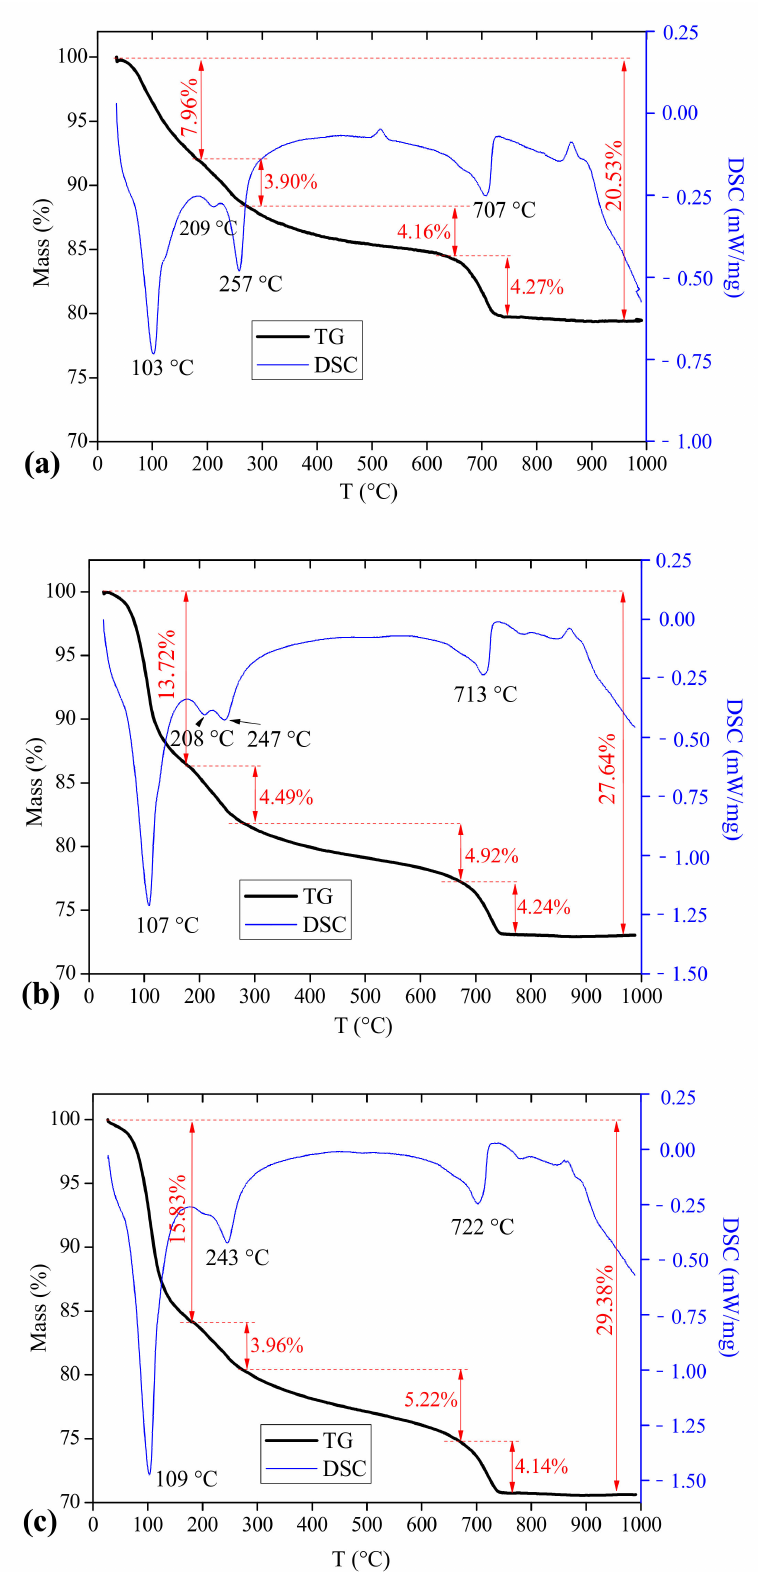
Figure 10. TG-DSC curves of the CSAC-GGBFS mixture with 6% FGDG hydrated for different time intervals. ( a ) 1 d, ( b ) 28 d and ( c ) 120